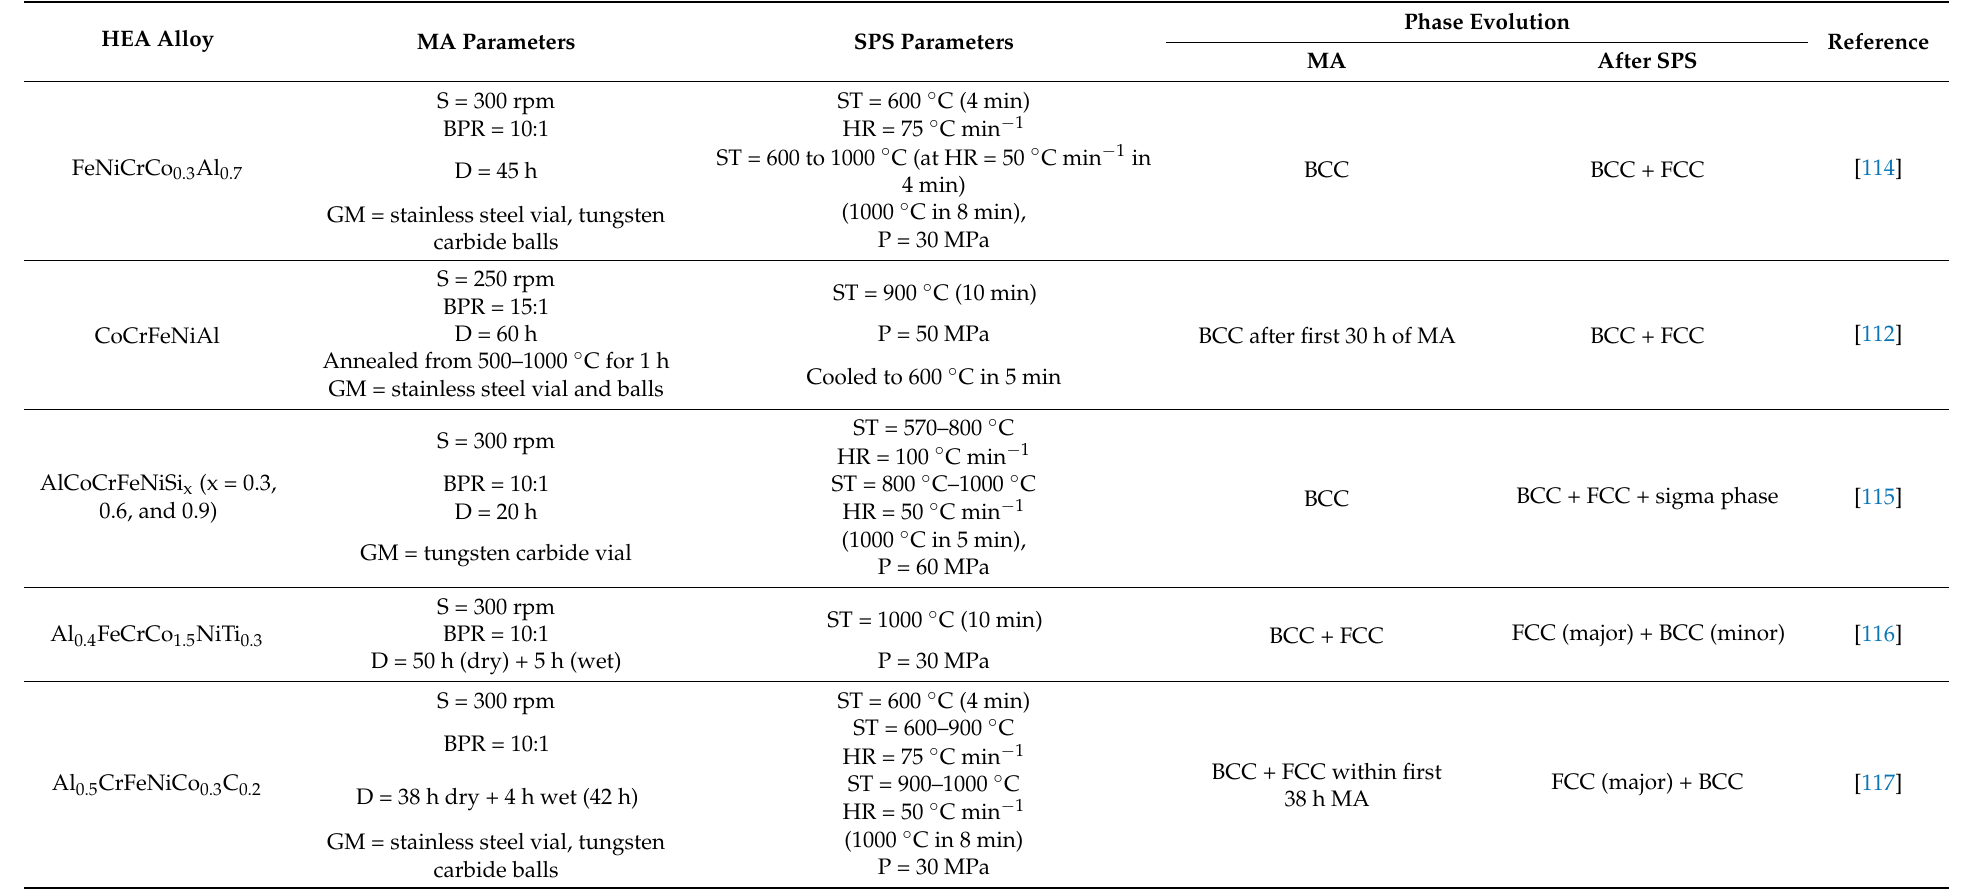
Table 2. Phase evolution of HEAs after MA and